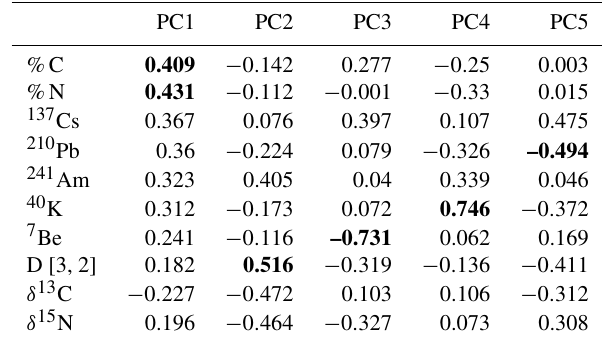
Table A4. Eigenvectors for principal components 1 to 5 from PCA of cryoconite data including gamma spectrometry ( 137 Cs, 210 Pb, 241 Am, 40 K, 7 Be), stable isotope analysis (%N, %C, δ 13 C, δ 15 N), and surface area-weighted particle size (D [3, 2]). The variables that have the largest effect on each principal component are in